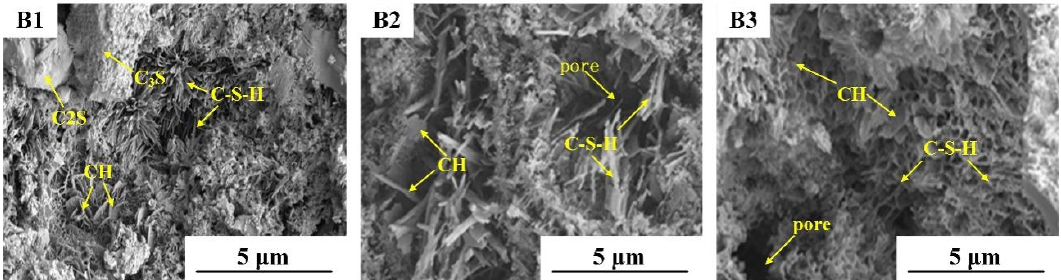
Figure 8. The SEM morphologies of cement matrix in specimens B1–B3 after 28 days curing time.